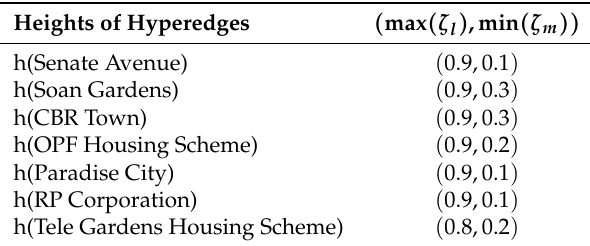
Table 7. Heights of